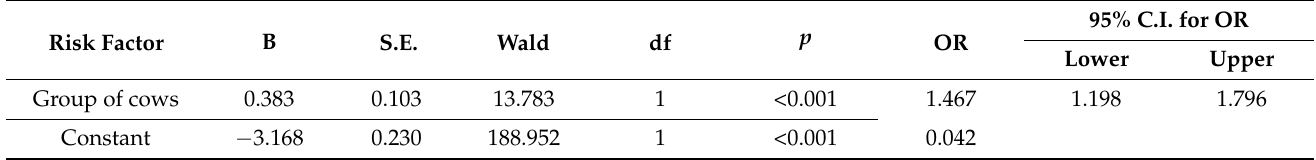
Table 2. Association of mastitis with stillborn calves and parity of dairy cows.